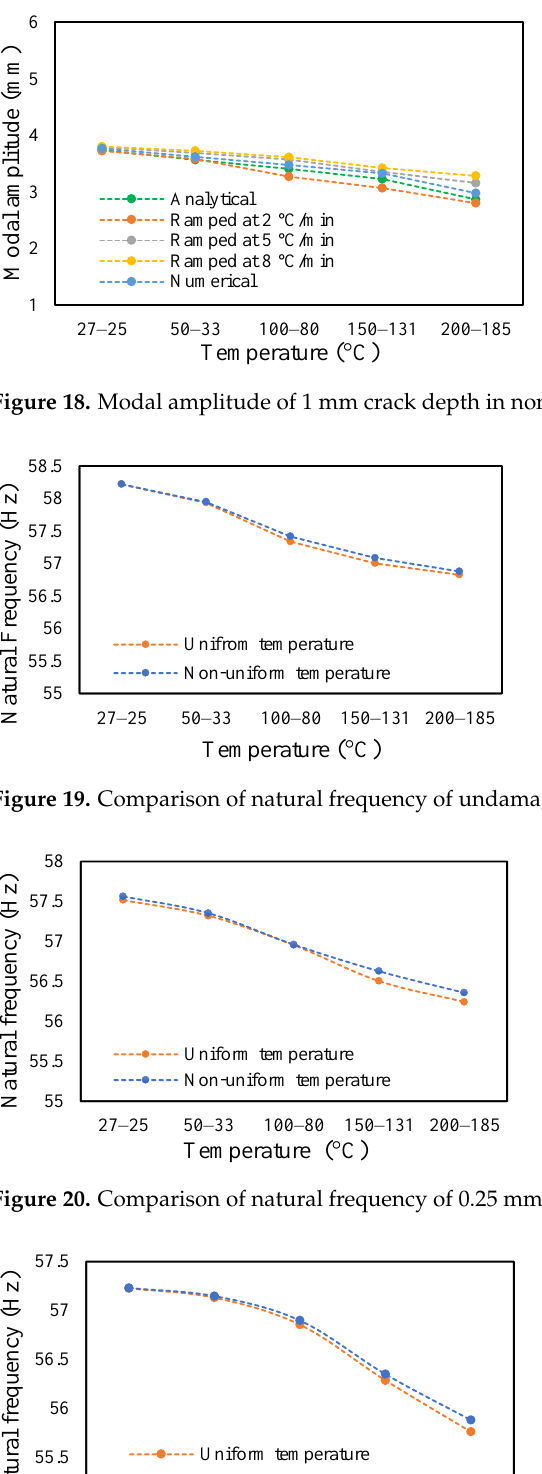
Figure 17. Modal amplitude of 0.5 mm crack depth in non-uniform temperature.